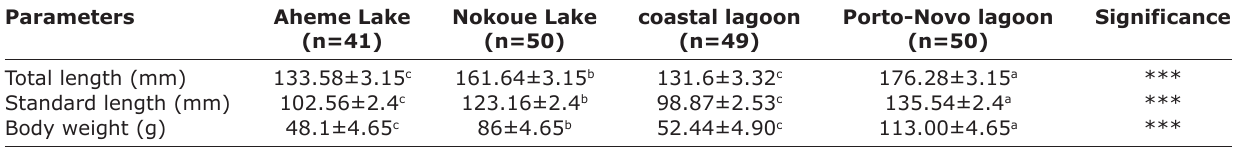
Table-2: Morphometric parameters of Sarotherodon melanotheron in different streams. Parameters